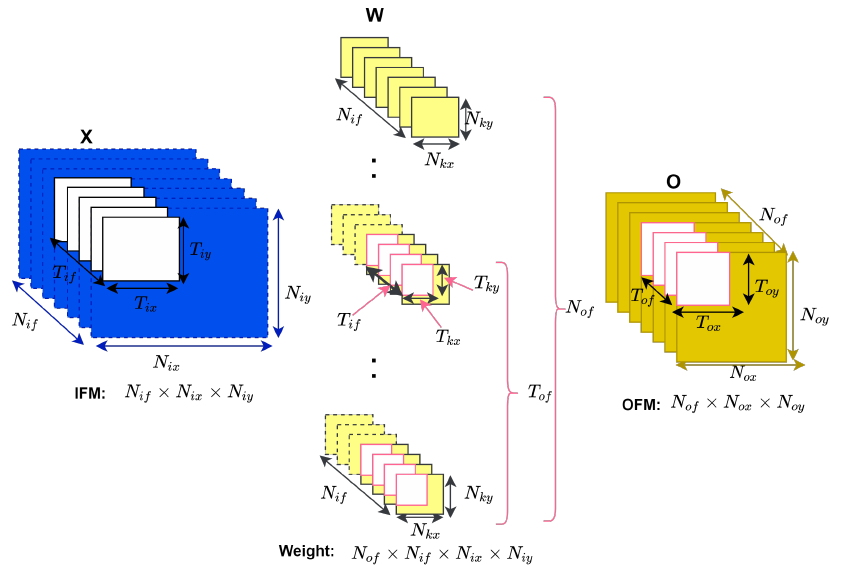
Figure 6. Convolution layer with loop tiling of the input, output and weight ‘pixels’ or ‘feature